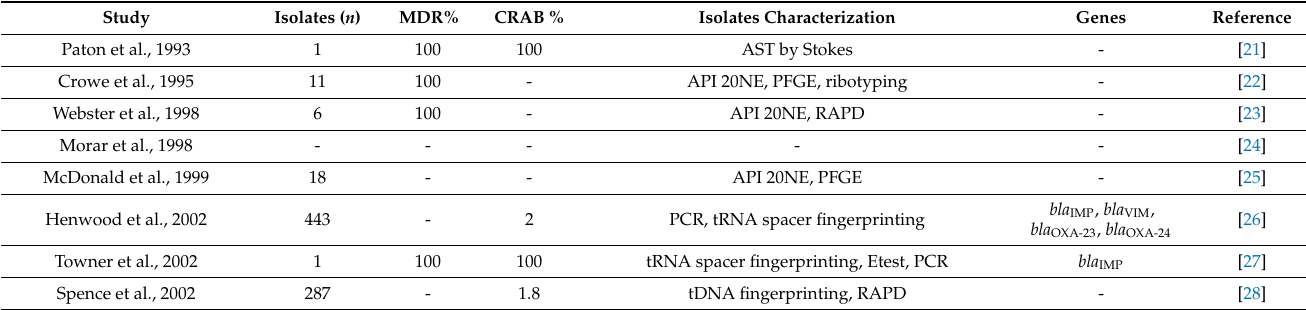
Table 1. A. baumannii studies from the United